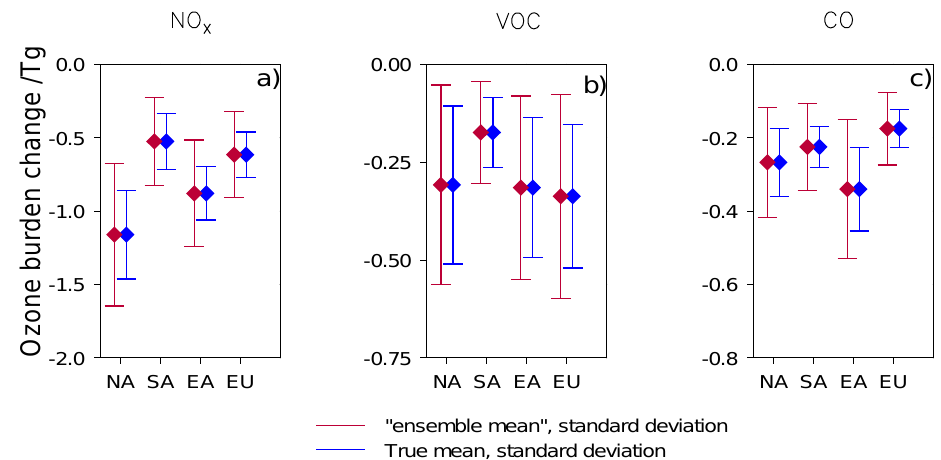
Figure 1. Change in global-mean atmospheric burden of short-lived ozone (in Tg), for (a) NO x , (b) VOCs, and (c) CO for the emission changes and emission regions given in Table 1. The ensemble mean and standard deviation fields calculated via the subsetting method used in Fry et al. (2012) (red lines) are constructed by calculating the mean and standard deviation of the model ensemble at each grid